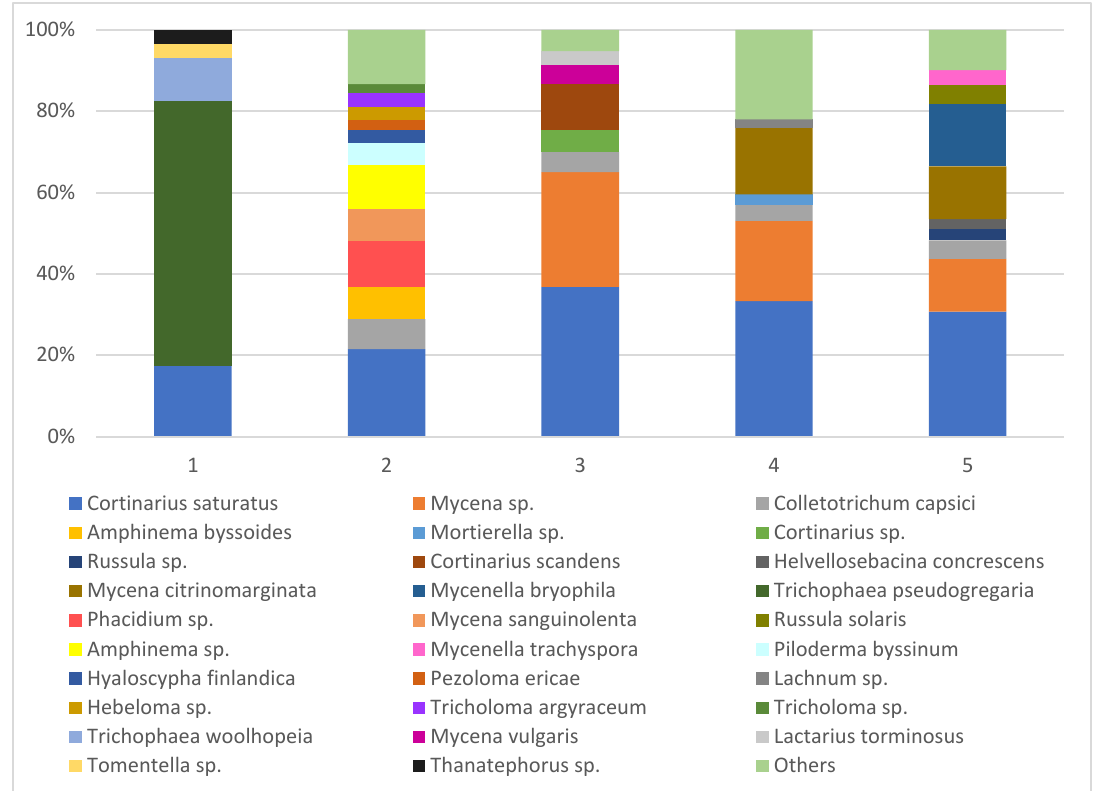
Figure 2. Fungal communities detected in the roots of orchids. (1) E. atrorubens (Dobšiná); (2) E. atrorubens (Jasenie); (3) P. bifolia (Jasenie); (4) E. pontica (Sirk); (5) C. longifolia (Sirk).